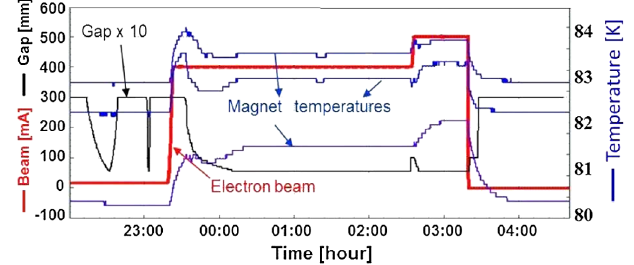
FIG. 19. Permanent magnet temperature variation versus gap at high electron beam current of 400 mA.